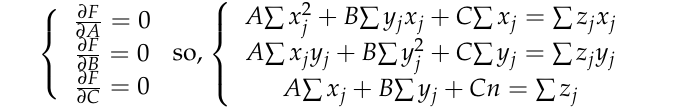
elevation points in